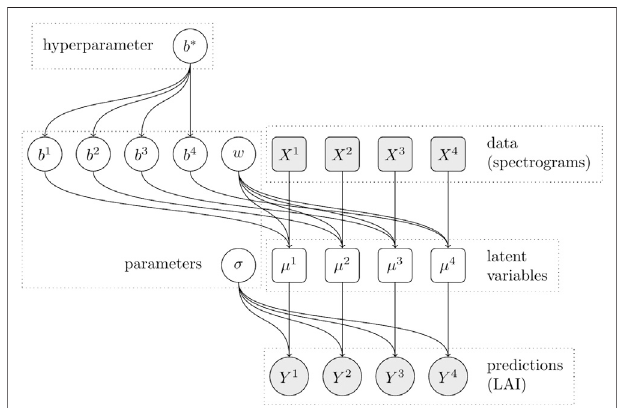
FIGURE 3 | Dependency graph of the hierarchical model with dataset- speci fi cbias terms. The predictions for each dataset j depend on an individual bias parameter b j , which in turn depends on the shared mean bias parameter b